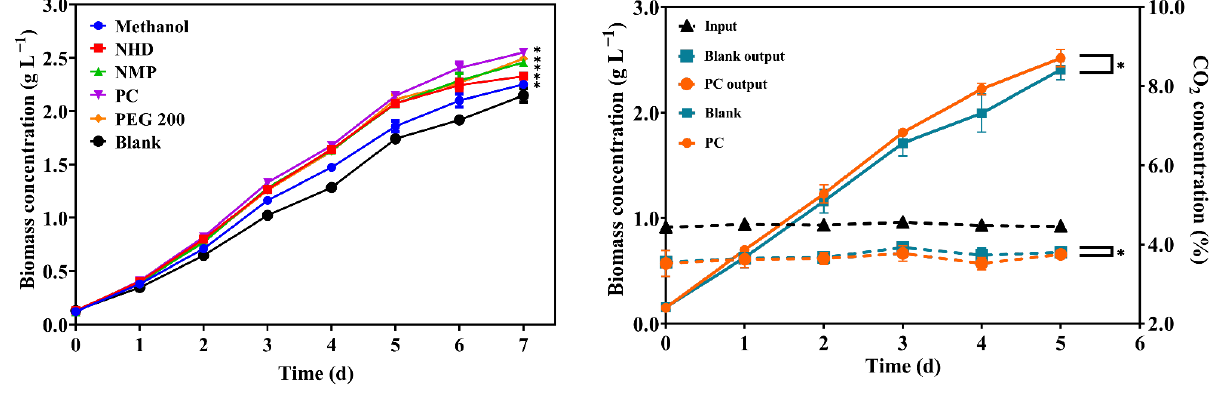
Figure 2. Growth of Scenedesmus sp. FSP3 with different CO 2 solubilization enhancers under 5% CO 2 ( A ). NHD: polyethylene glycol dimethyl ether, NMP: N-methylpyrrolidone, PC: propylene carbonate, PEG200: polyethylene glycol 200. ( B ) The input and output CO 2 concentrations of the microalgae cultures (the dotted line) and the growth (the solid line) of Scenedesmus sp. FSP3 with PC added under 5% CO 2. (Input: the concentration of CO 2 into the medium with PC added and blank; PC output: the effluent CO 2 concentration of the medium with PC added; Blank output: The effluent CO 2 concentration of blank; PC: the growth of Scenedesmus sp. FSP3 in the medium with PC added; Blank: the growth of Scenedesmus sp. FSP3 in the blank. Dunnett’s test was performed to determine statistically significant difference: *, p < 0.05, n = 3.